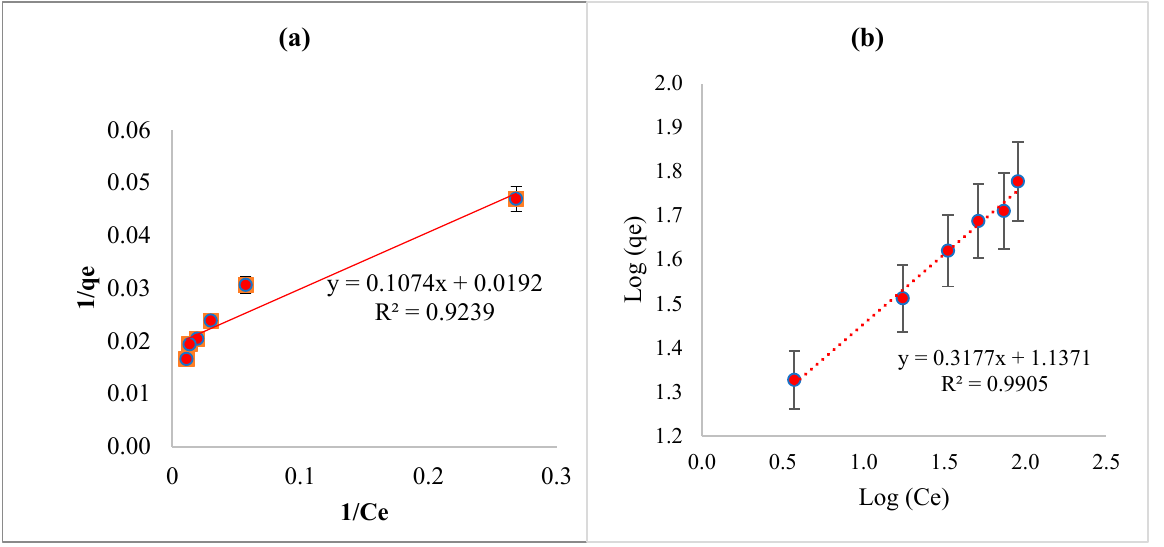
Figure 13. ( a ) Langmuir isotherm of red hair dye onto COZ, and ( b ) Freundlich isotherm of red hair dye onto COZ.